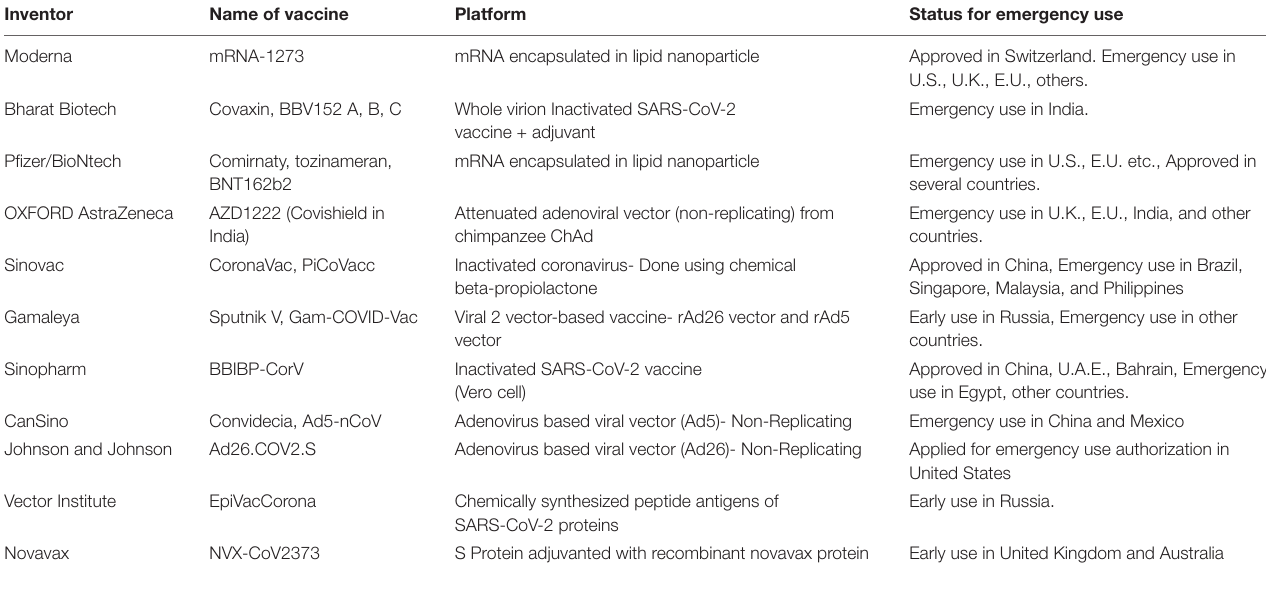
TABLE 3 | List of COVID-19 marketed vaccines: manufacturers, trade names, platforms and existing status of approval for usage in various countries are mentioned in the representative